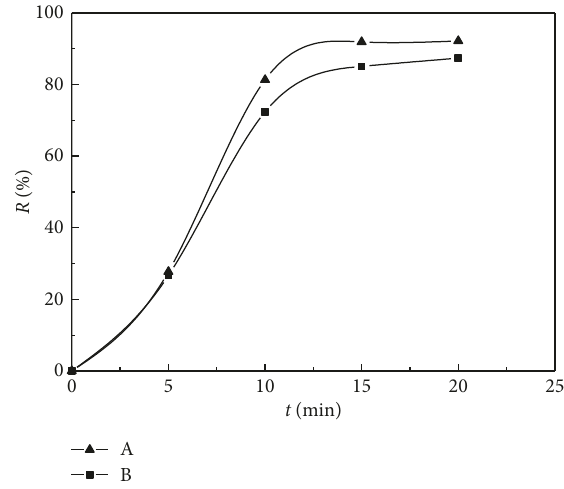
Figure 2: Variation of reduction degree of carbon-containing pellets of different C/O ratios with time at 1200 °